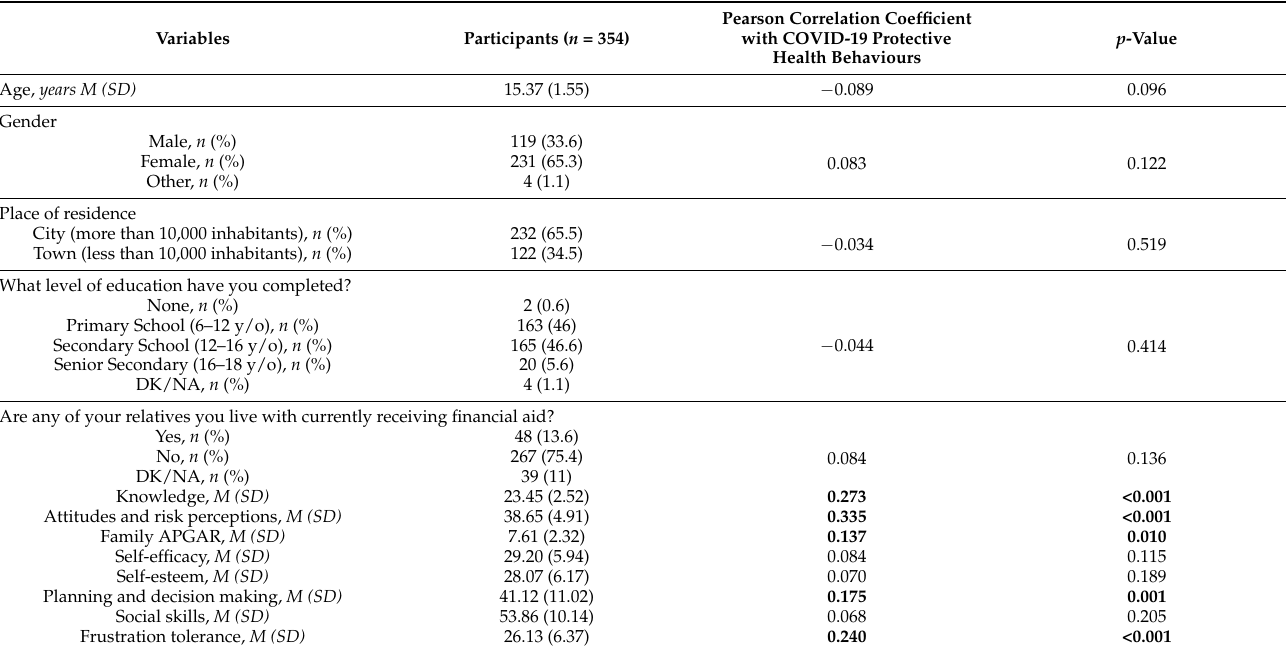
Table 1. Sociodemographic characteristics, knowledge, attitudes, and risk perceptions, COVID-19 protective health behaviours and psychological variables of the sample.